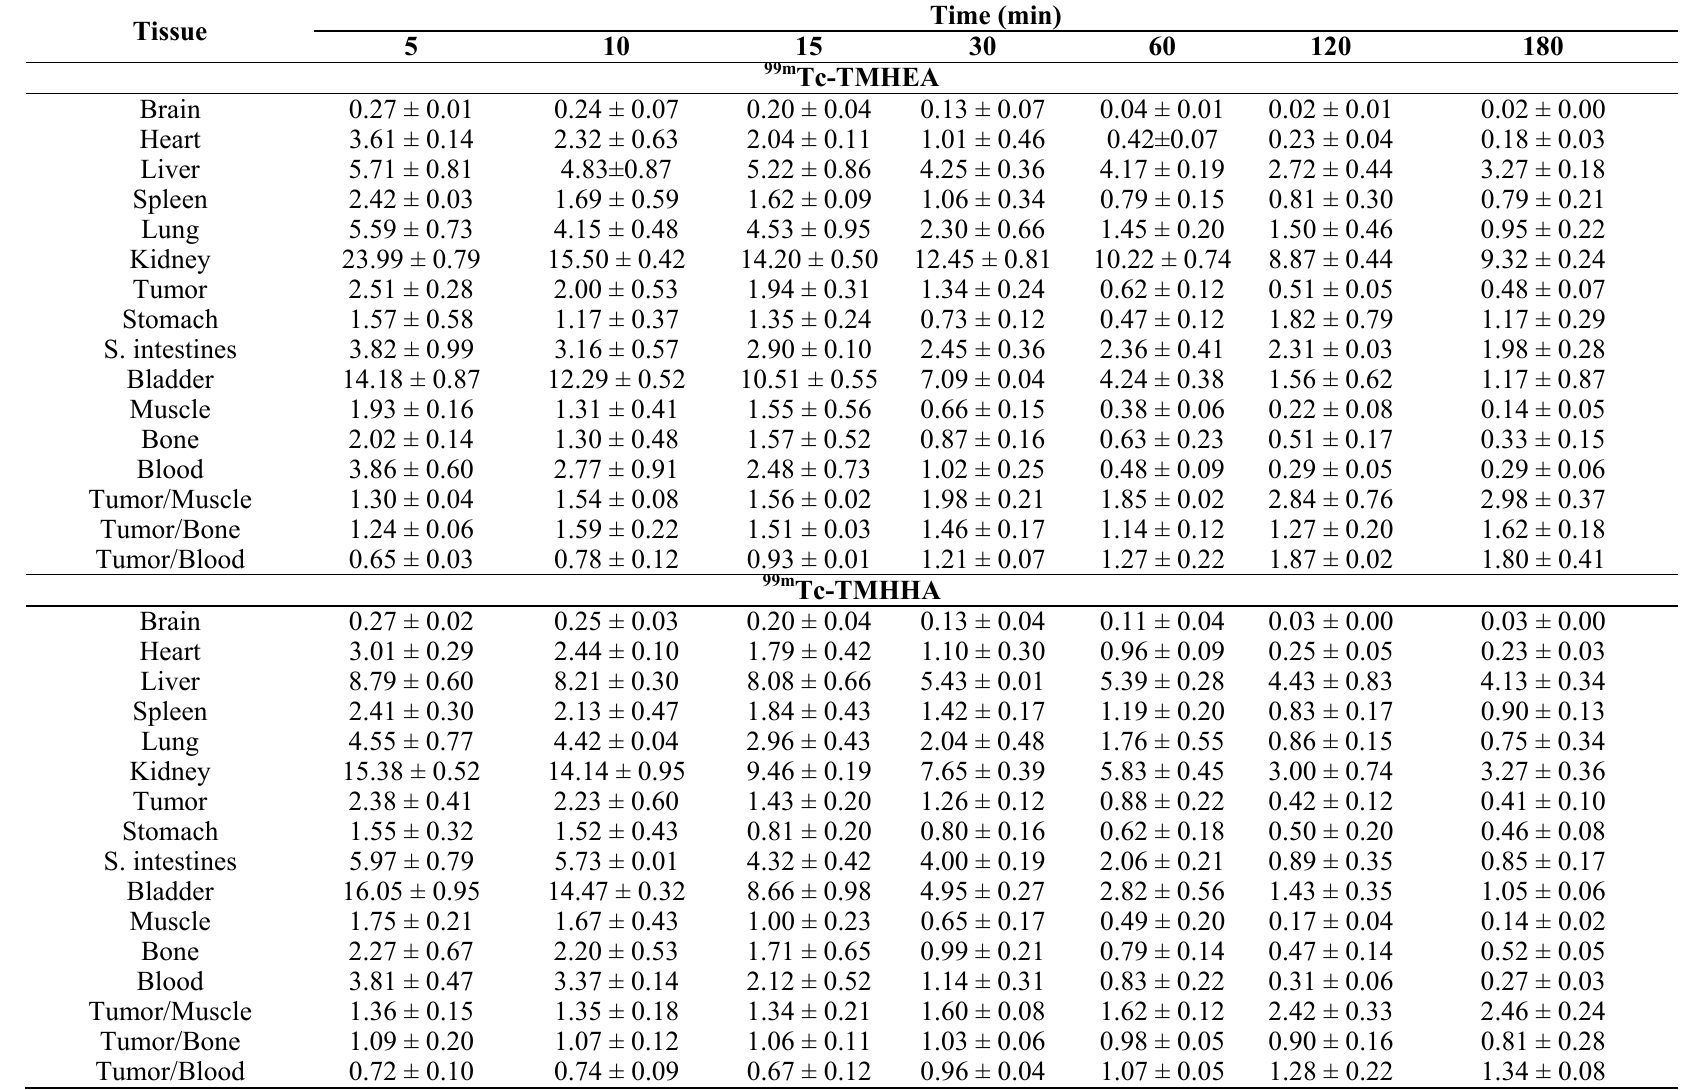
Table 3. Biodistribution of 99m Tc-TMHEA and 99m Tc-TMHHA in mice (mean ± SD, n = 5,